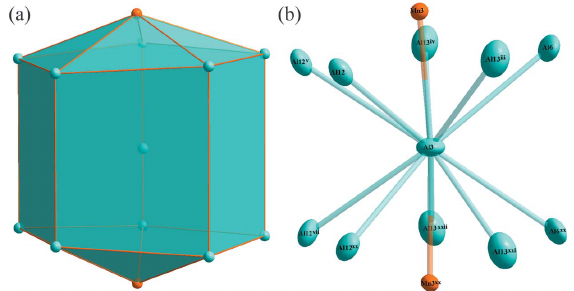
, (cid:3) y + 3 , (cid:3) z + 1; (iv) 2 2